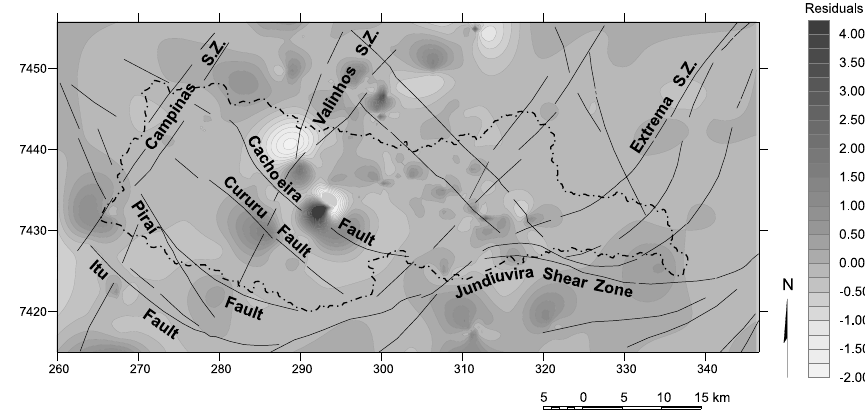
Fig. 6 – Specific capacity residual map of wells that exploit the Crystalline Aquifer System and its relation with shear zones and regional faults.